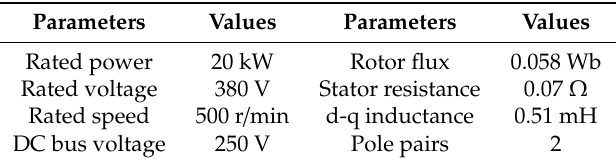
Table 1. Main parameters of a three-phase PMSG